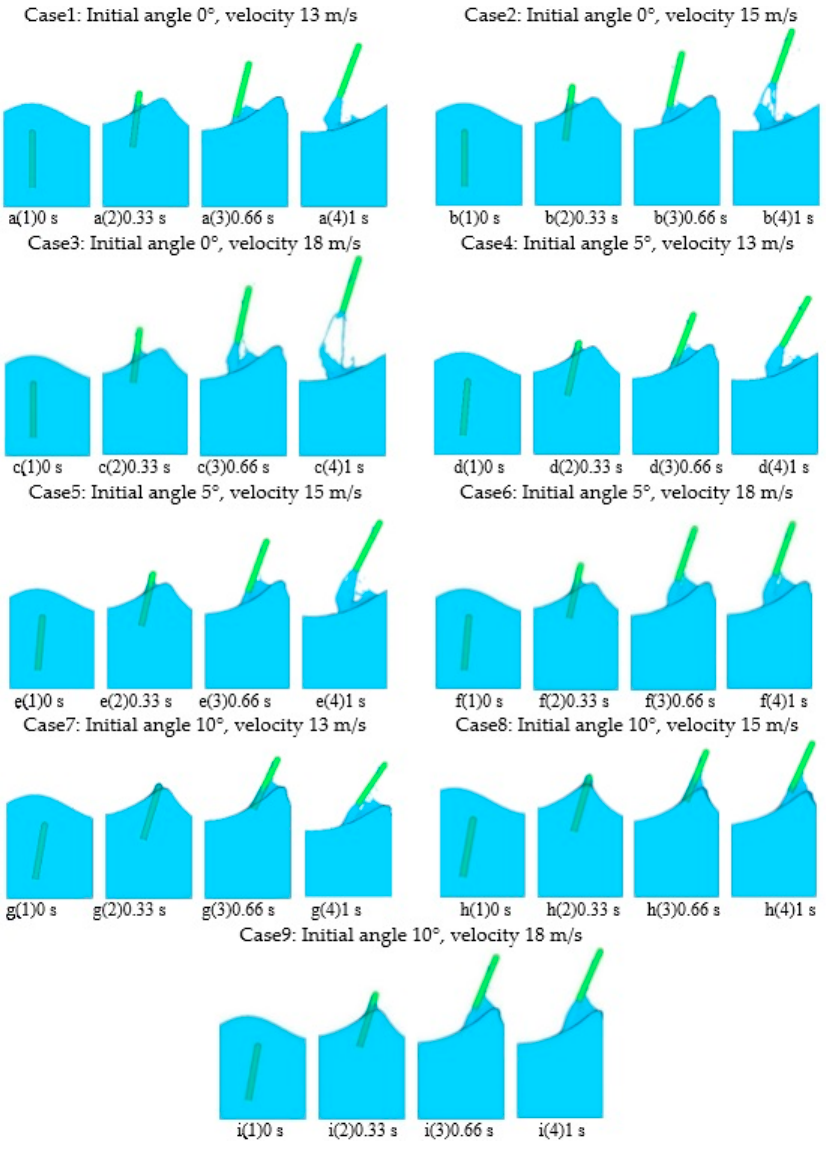
Figure 6. Image of vehicle fl ying out of water.